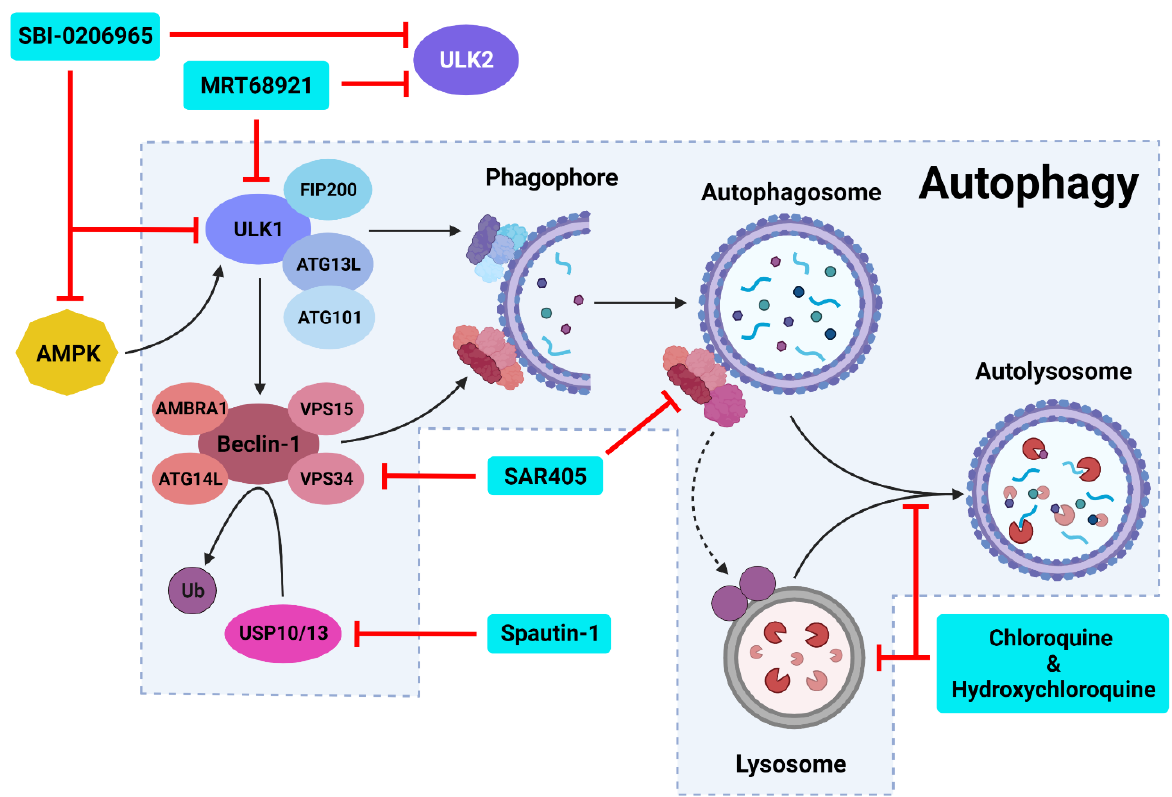
Figure 5. Autophagy Inhibitors Targeting Different Arms of the Autophagic Pathway. SBI- 0206965 inhibits AMPK, ULK1 and ULK2 to prevent autophagic initiation. MRT68921 inhibits ULK1 and ULK2 to prevent autophagic initiation. SAR405 inhibits VPS34 on the PI3KC-C1 and PI3KC-C3 to suppress initiation and fusion stages. Spautin-1 inhibits USP10 and USP13 to promote UPS-mediated degradation of Beclin-1. CQ/HCQ inhibit the lysosomal activity and fusion with autophagosomes. Created with BioRender.com (accessed on 27 January 2022)